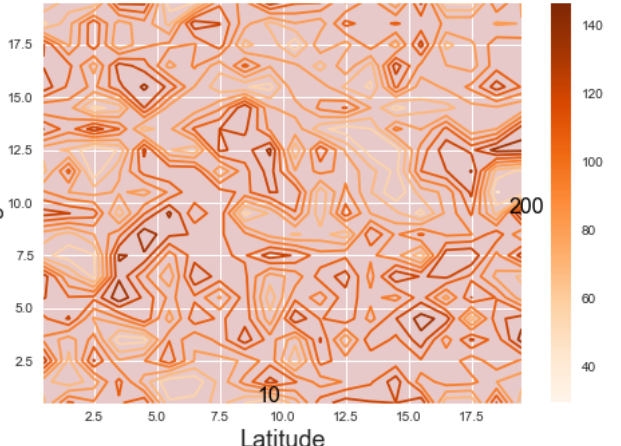
Figure 5. Contour map of simulated data for the dependent variable with the contaminated locations.